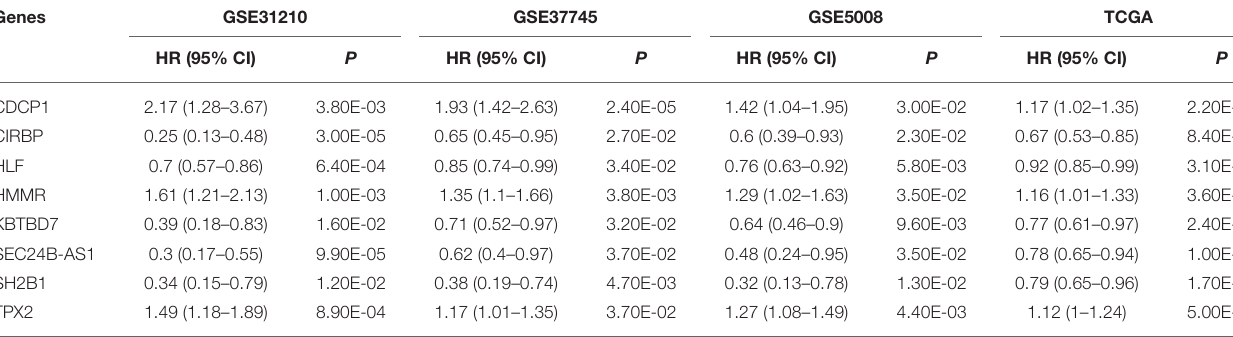
TABLE 2 | Univariate regression analysis of 8 genes and overall survival of NSCLC patients in 4 datasets.